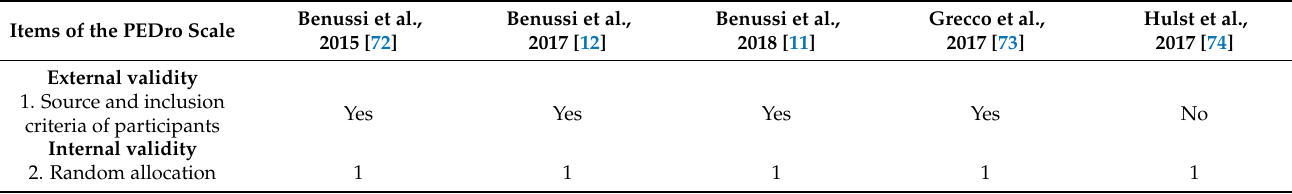
Table 2. Scores of the PEDro scale for each selected